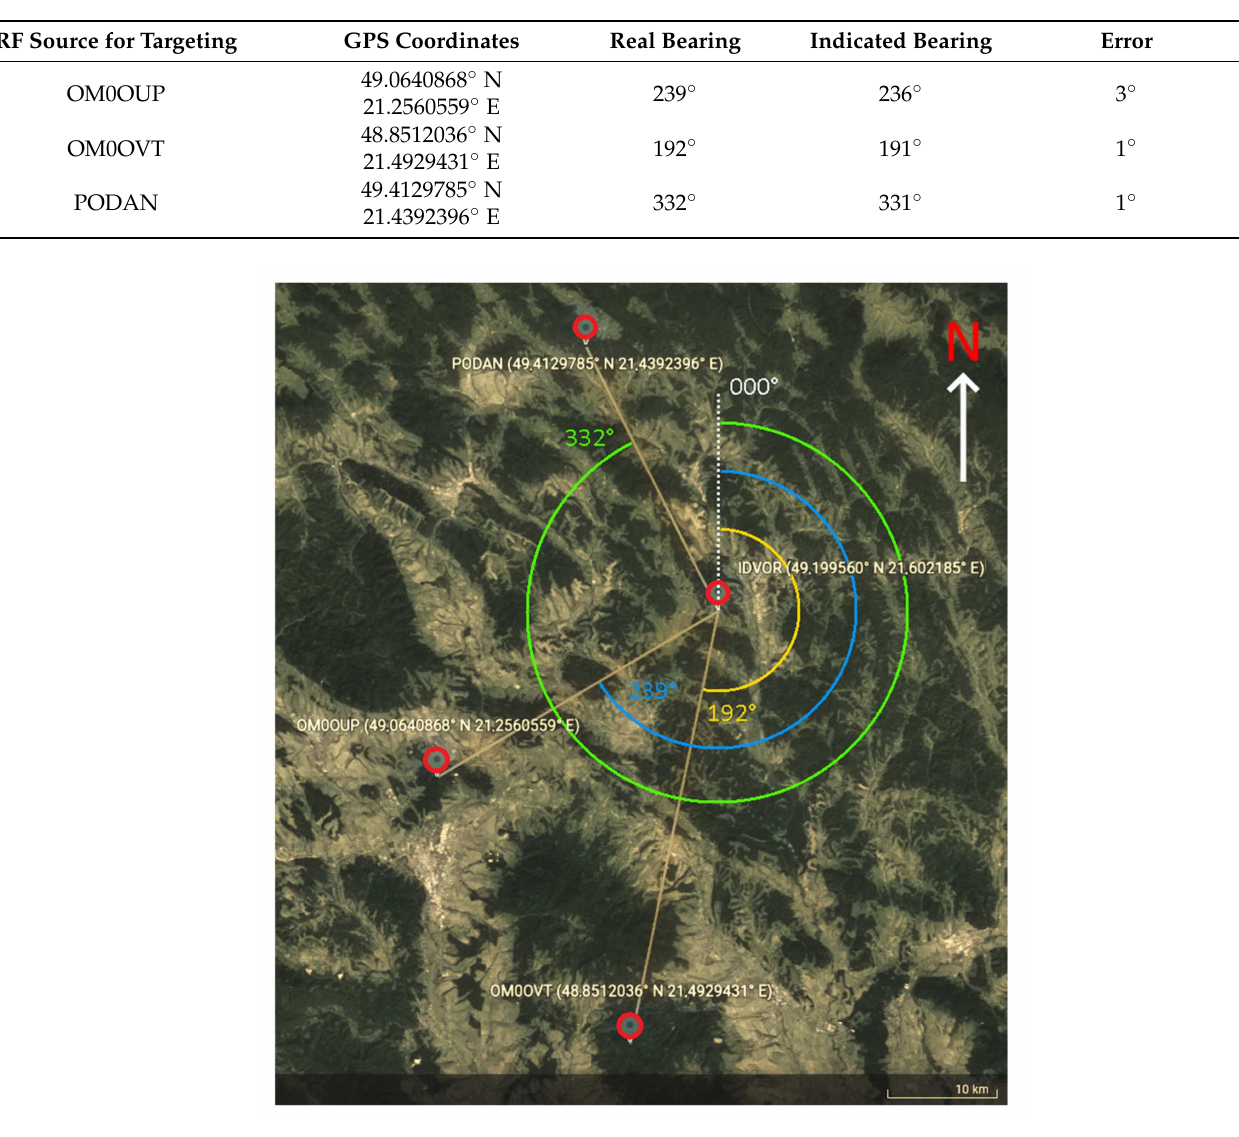
Figure 10. Location of testing points for evaluations of